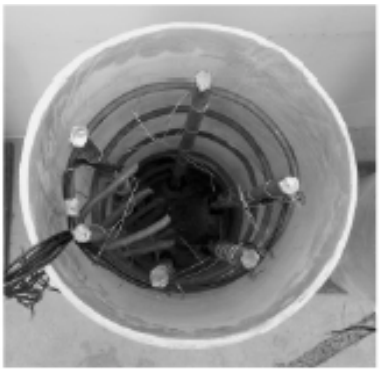
Figure 1. Glass fiber reinforced polymer (GFRP) tubes with GFRP bars.